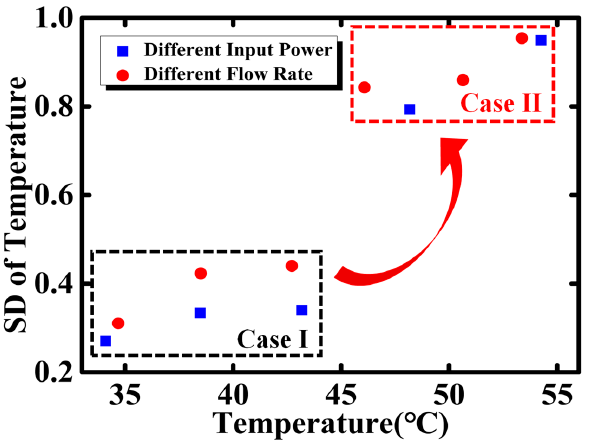
Figure 3. The calculated standard deviation of the temperature with the different input power (1.5, 2.0, 2.5, 3.0, and 4.0 W, but a constant flow rate 50 mL/h) and different flow rate (70, 80, 90, 120, 150, and 200 mL/h) but a constant heating power of 5.5 W.